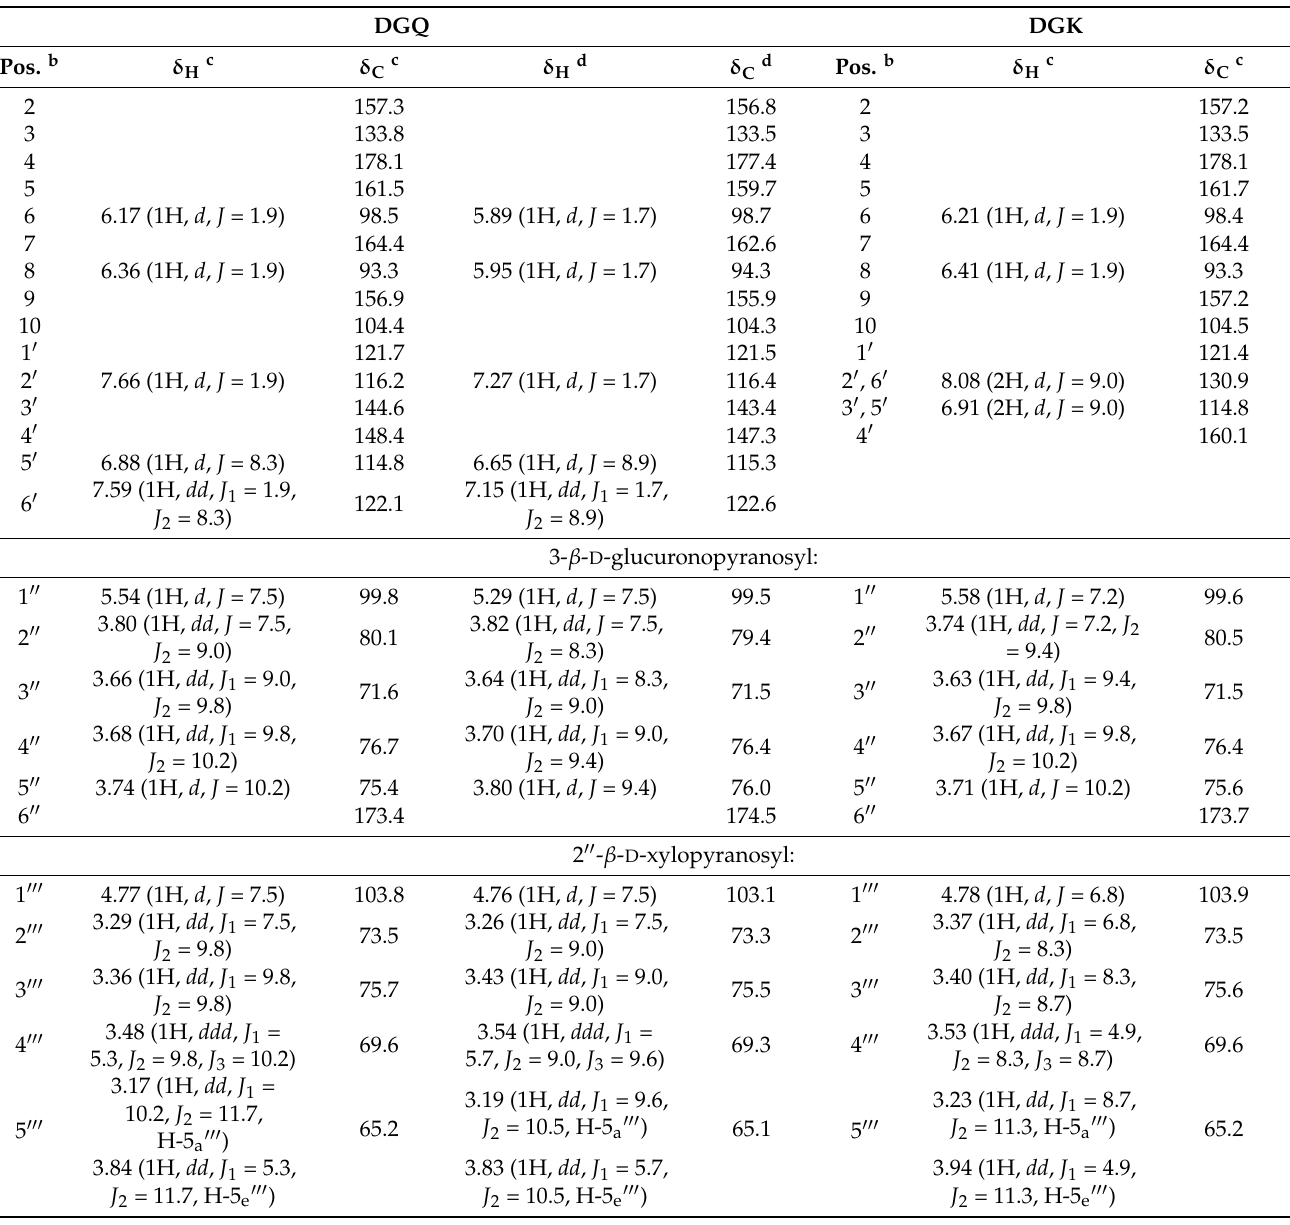
Table 1. NMR spectral data of compound DGQ in methanol- d 4 and water- d 2 and compound DGK in methanol- d 4 (600 MHz for 1 H and 150.9 MHz for 13 C) a